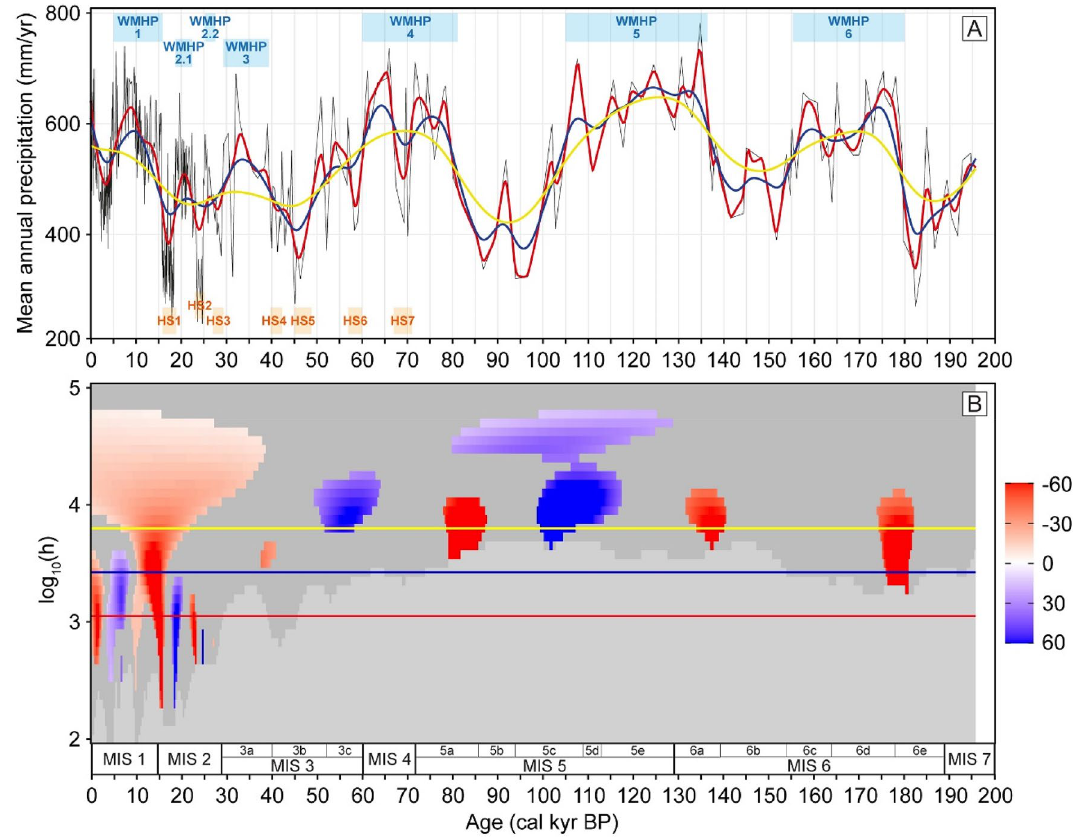
Figure 3. SnSiZer analysis developed on the Padul MAP reconstruction, showing the statistically significant changes of the data for the last 200 kyr. On the top panel ( A ), we show the raw MAP reconstruction with different Nadaraya-Watson smoothing levels (red-blue-yellow lines) along with the WMHPs and HSs. On the bottom panel ( B ), reading from past to present (from right to left), the red and blue colors indicate the statistically significant precipitation increases and decreases, respectively. The vertical axis represents the level of smoothing in logarithmic units and the horizontal red-blue-yellow lines the smoothing levels as in the upper panel. Dark grey areas represent no significant changes and light grey areas represent where the sampling resolution is too